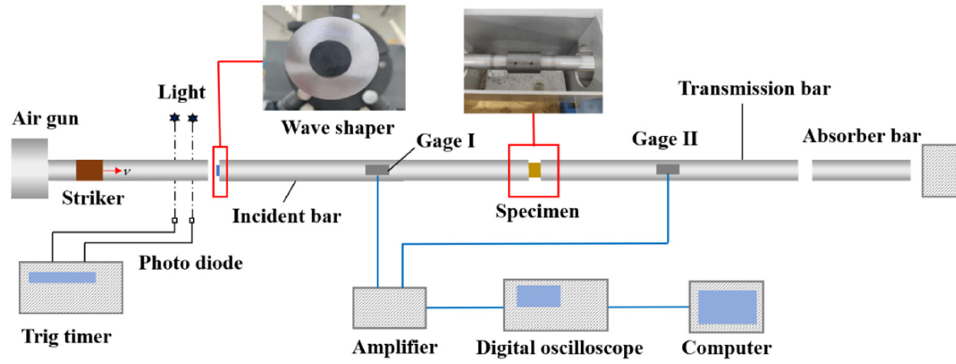
Figure 4. System composition of SHPB test setup.